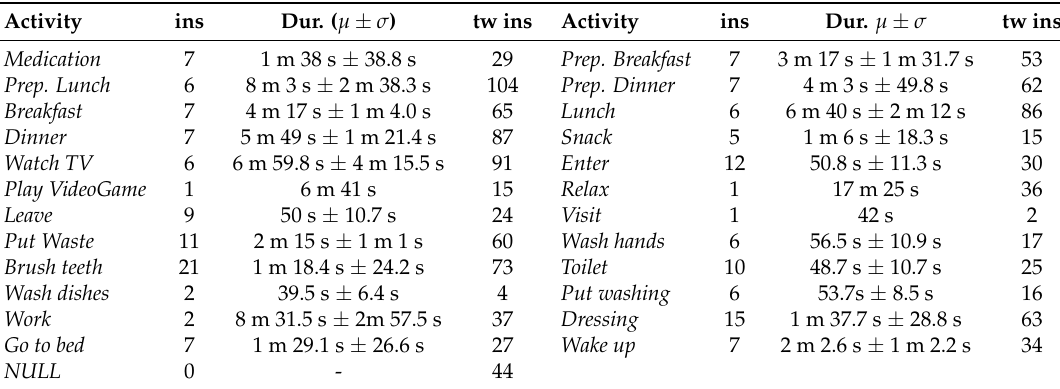
Table 1. Summary of activity classes and their distribution in the